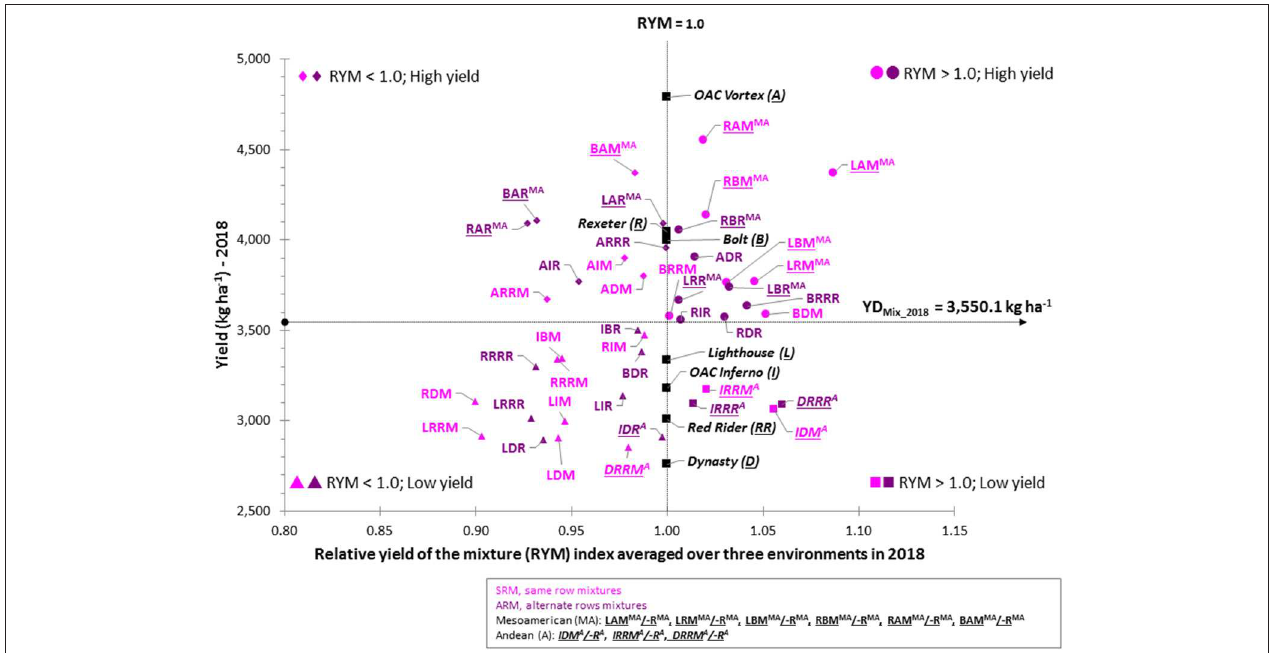
FIGURE 7 | Comparison of the yield and relative yield of the mixture (RYM) index in common bean averaged over three Ontario environments/locations in 2018. In each scatter plot, horizontal line indicates the mean value of the yield; vertical line indicates RYM value of 1 and connects cultivars in pure stands. Plot is divided into four quadrants: top right, mixtures having RYM > 1 and high yield (best performers); bottom right, mixtures having RYM > 1 but yield lower than the average; top left are mixtures with RYM < 1 and high yield; bottom left are mixtures with RYM < 1 and low yield (worst